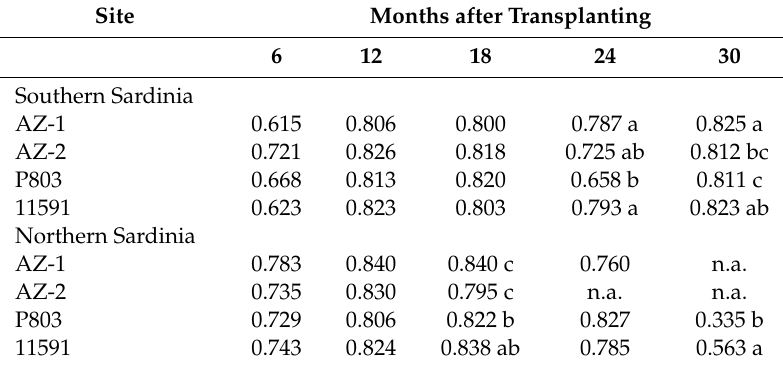
Table 6. Leaf chlorophyll fluorescence (Fv / Fm) of guayule lines from transplanting to harvest at 30 months at the two